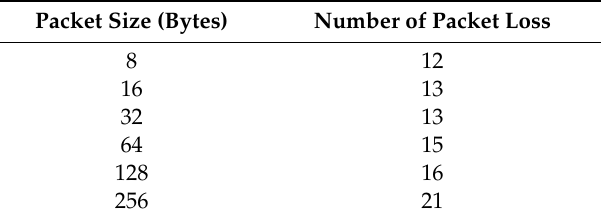
Table 3. Network packet loss at di ff erent packet